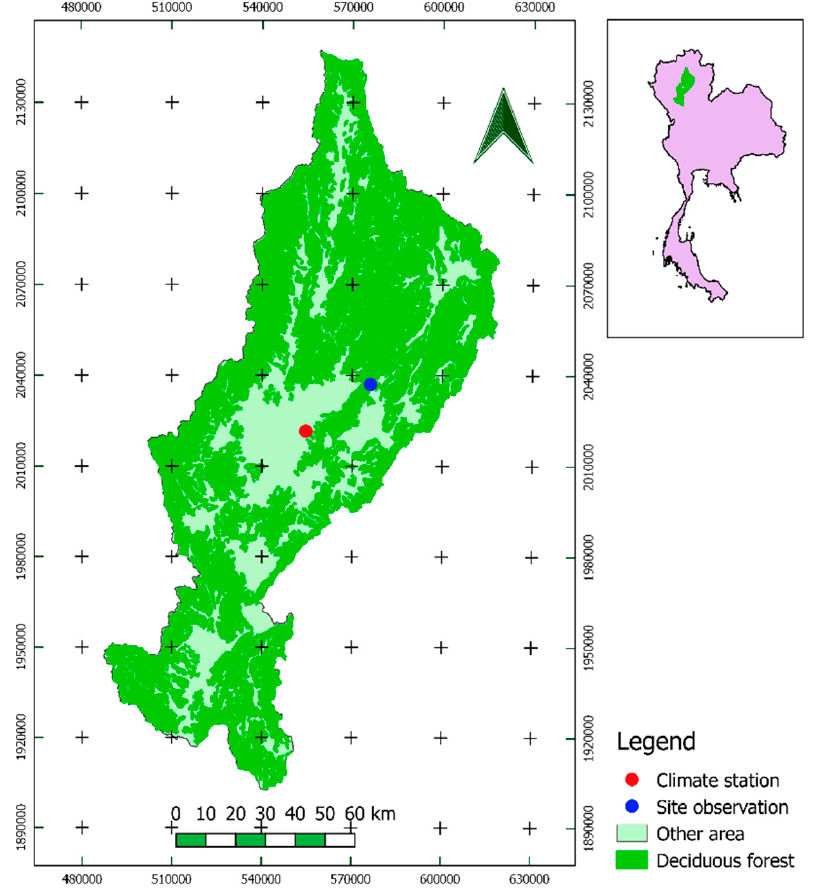
Figure 1. Location of study area and extent of Thailand forest map (Thai Royal Forest Department 2007/2008); the red dot shows the location of climate station; the blue dot shows the location of site observation where the in situ leaf area index (LAI) was collected.